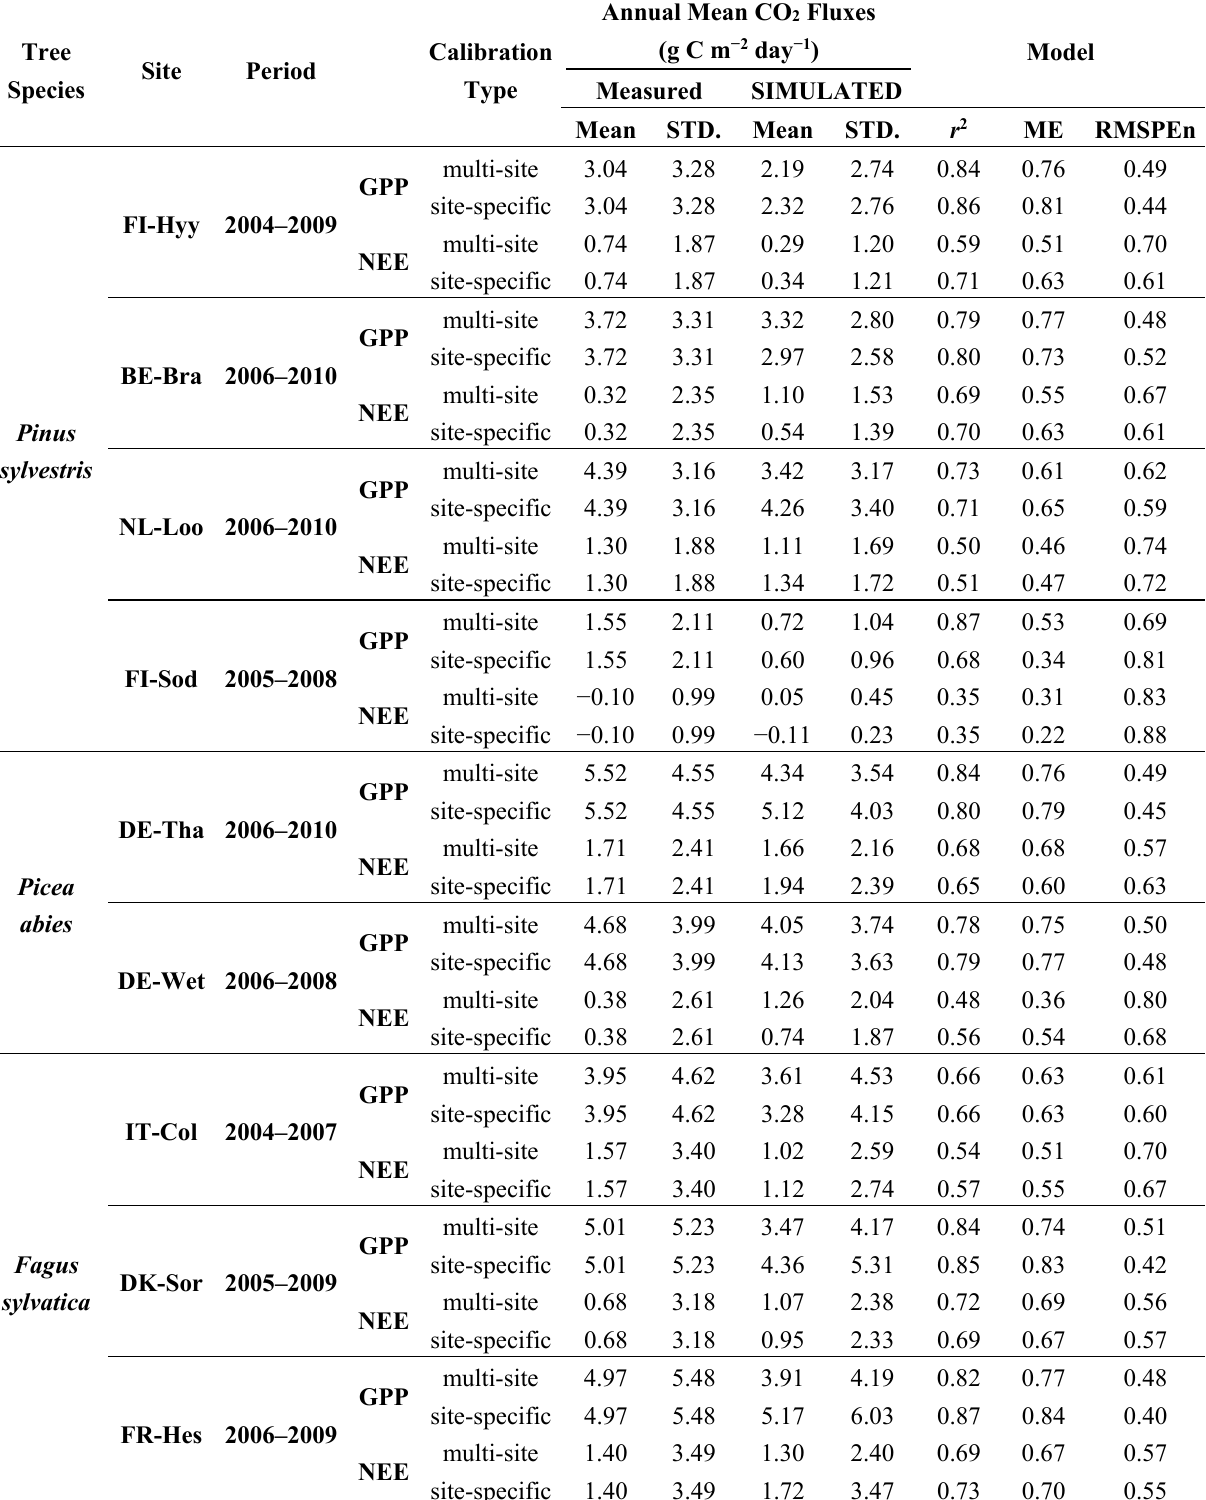
Table 6. Annual means of daily measured and simulated GPP and NEE fluxes obtained with either site-specific or multi-site derived parameters (annual daily means represent >320 measurement points per years at most sites). Abbreviations: ME: model efficiency, RMSPEn: normalized root mean square prediction